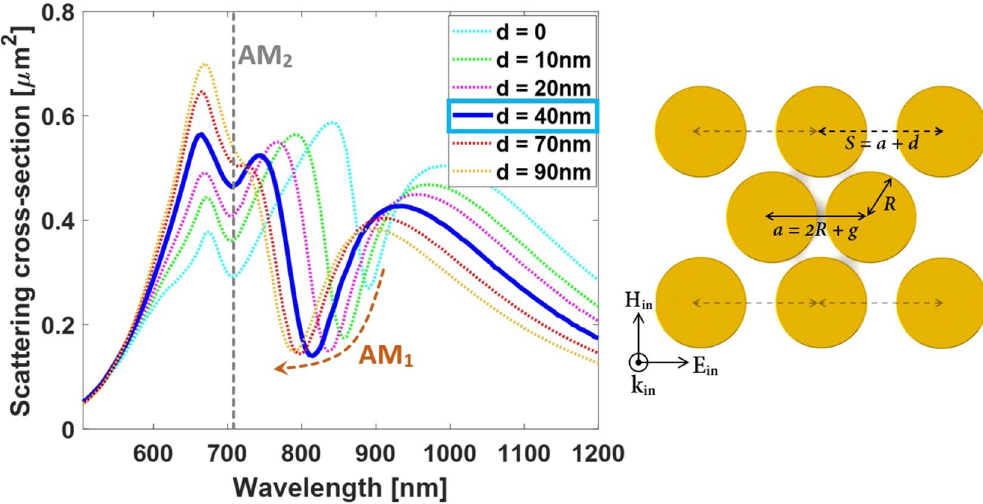
Figure 6. Simulated total SCS of our proposed oligomer considering various gap distances for corner particles denoted by the deviation S = a + d . The other geometrical parameters are chosen as the same as those in